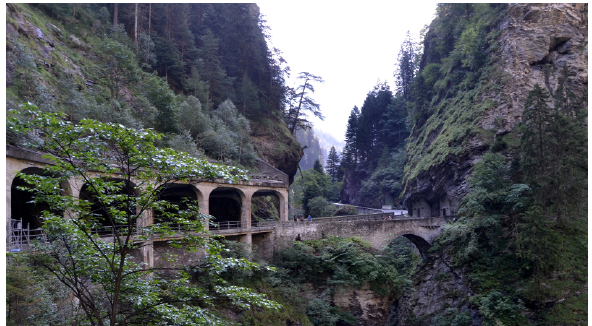
Figure 1: Rockfall protection structures and bridges in a 300 m deep gorge (Viamala, Thusis, Switzerland), where the GNSS re- ception is absent or unreliable for autonomous UAV